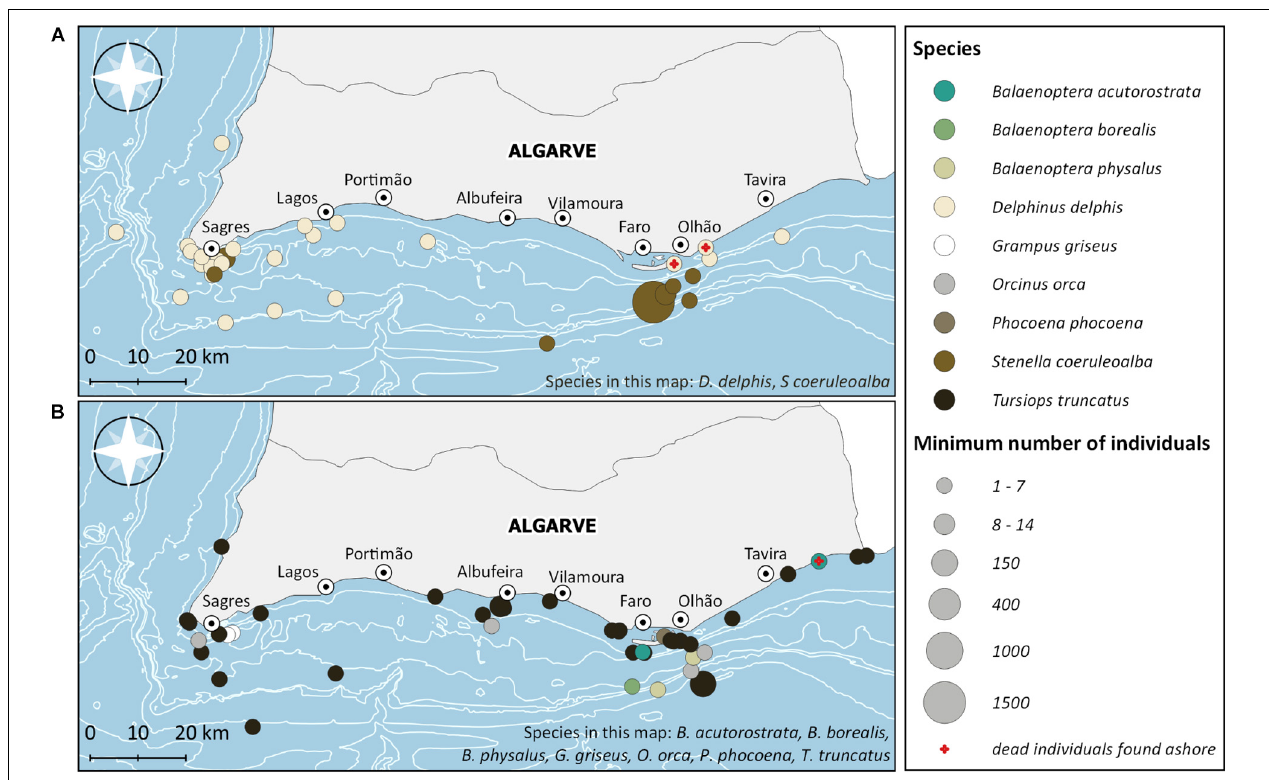
FIGURE 7 | Location and the minimum number of individuals of nine cetacean species recorded on Biodiversity4All between 2008 and 2020, including dead individuals found ashore. Records are displayed in two panels to avoid the superposition of observations: (A) Delphinus delphis , Stenella coeruleoalba ; (B) Balaenoptera acutorostrata , Balaenoptera borealis , Balaenoptera physalus , Grampus griseus , Orcinus orca , Phocoena phocoena , Tursiops truncatus . Two records out of the 82 valid records obtained from Biodiversity4All were not included in this map because the coordinates placed the observations inland (